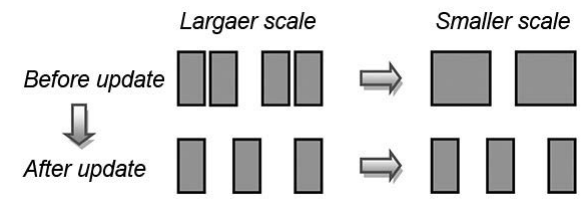
Fig. 6. Cases of reducing an aggregated feature